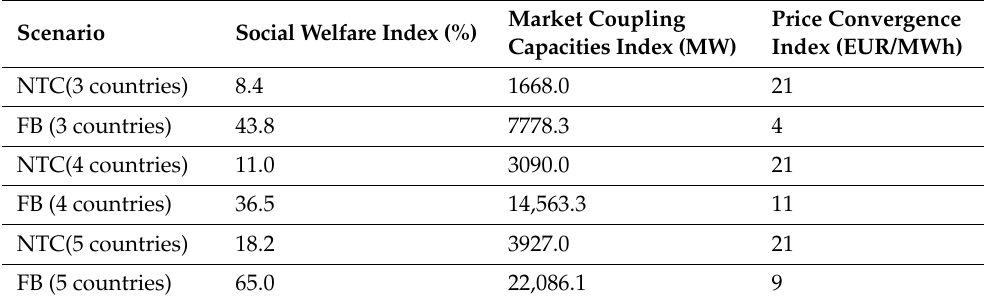
Table A4. Indexes for 19th of June.